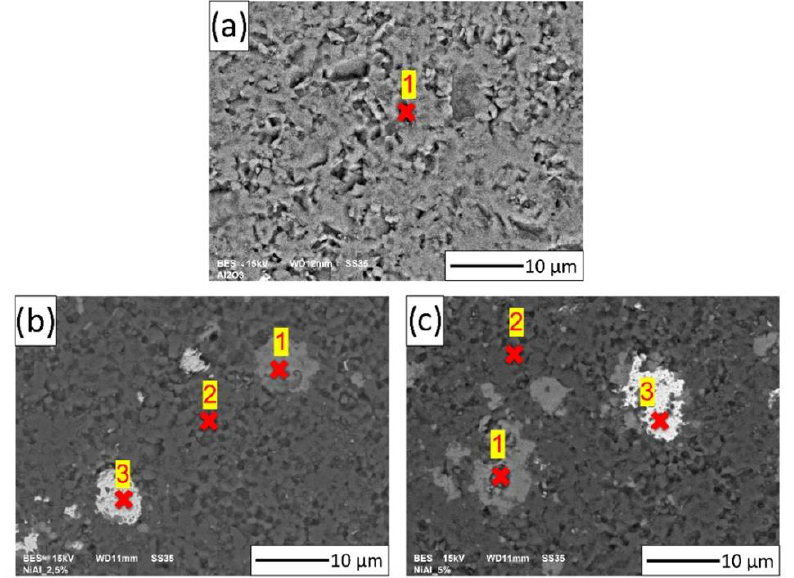
Figure 12. Analysis of the chemical composition for the selected points in the samples: ( a ) Series I— 100 vol.% of Al 2 O 3 ; ( b ) Series II—Al 2 O 3 + 2.5 vol.% of NiAl + 30 wt.% A 2 O 3 ; ( c ) Series III—Al 2 O 3 + 5 vol.% of NiAl + 30 wt.% A 2 O 3 . Table 3. The weight content of the samples from different points.